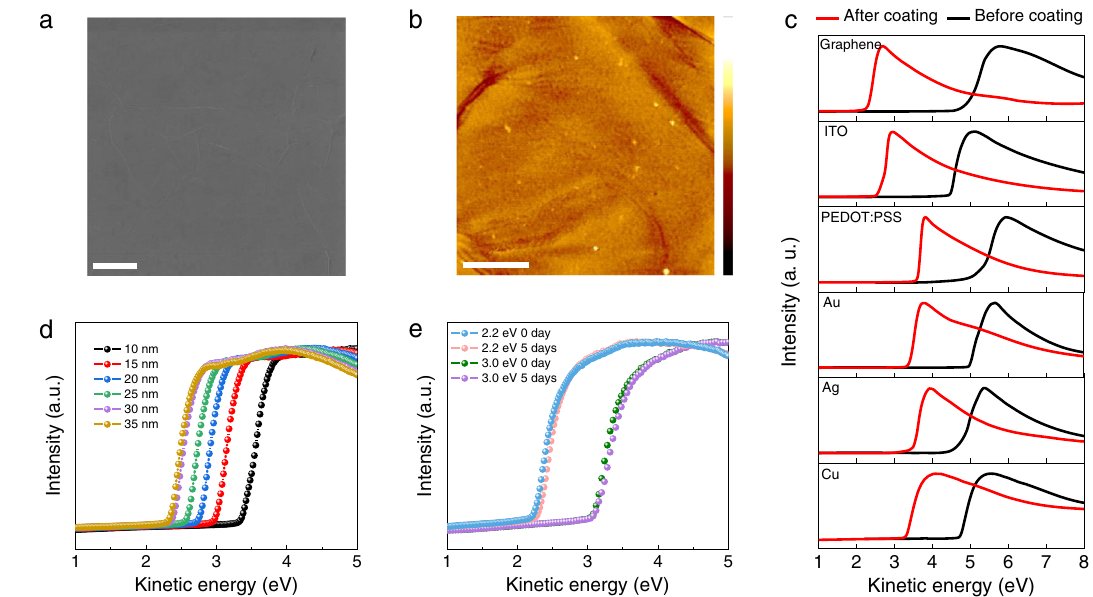
Fig. 3 | WF modi fi cation of various conductors with TPHP(LiClO 4 ). a , b Helium ion microscope (HIM) ( a ) and atomic force microscope (AFM) ( b ) images of TPHP(LiClO 4 )-coated graphene on thermal release tape (TRT) substrate. The scale bars in ( a ) and ( b ) are 1 μ m, and height scale in ( b ) is from − 5 to 5nm. c Photoemission cutoff obtained via UPS for graphene, ITO, PEDOT: PSS PH1000,